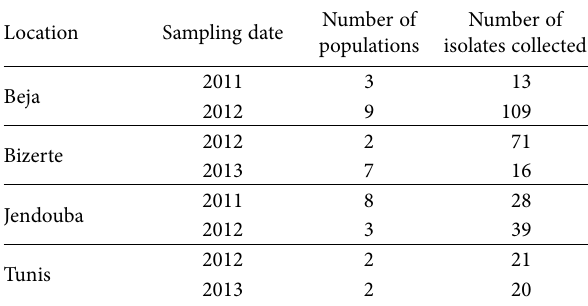
Table 1. Origin of Ascochyta fabae isolates (location, sampling date) used in the